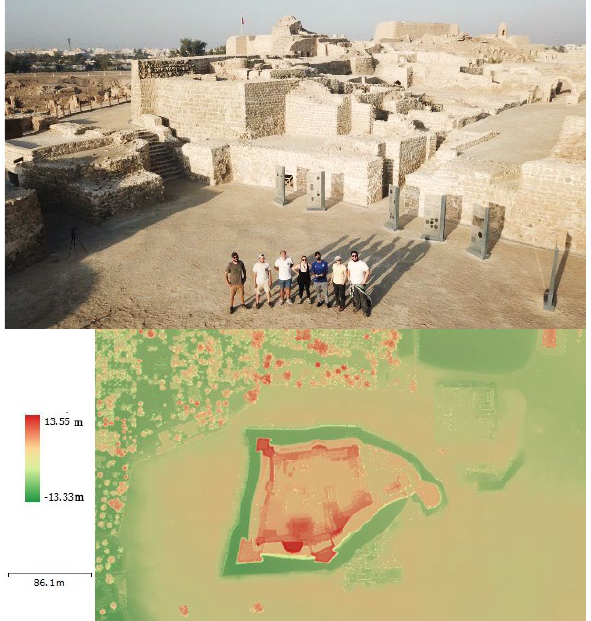
Figure 2. The team during the survey mission, June 2021 (upper). The Digital Surface Model (DSM) of the surveyed area by UAV photogrammetry (bottom). Source: authors and BACA.